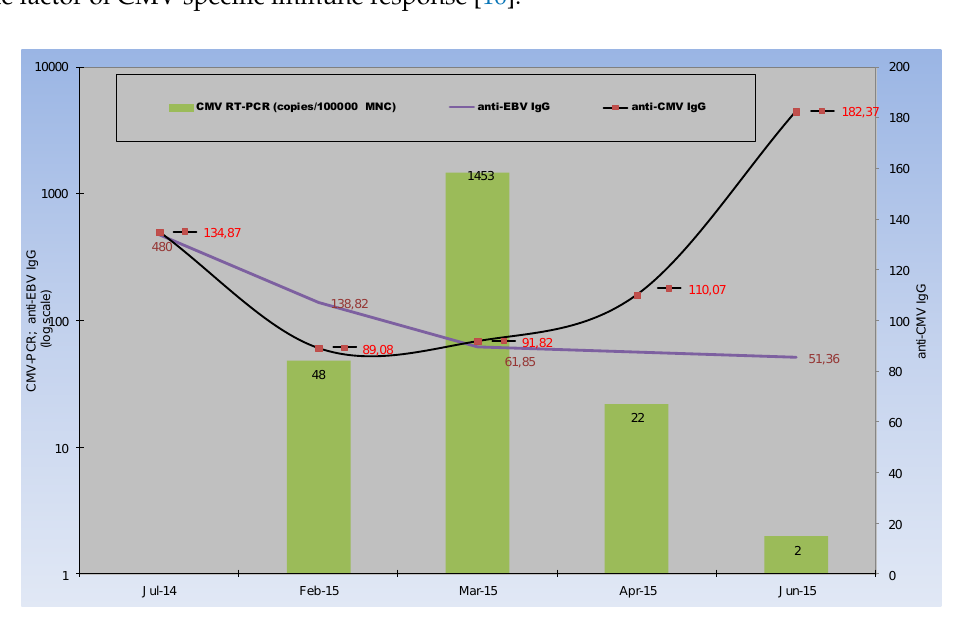
Figure 2. CMV-specific evolution during infancy. The diagram shows the timeline with the results presented on the vertical axes anti-CMV IgG (right) as well as anti-EBV IgG and viremia (left vertical axis). Mild and unspecific symptoms of viremia were observed when the passive-acquired maternal IgG disappeared. Increase of specific IgG corresponds with virus clearance. For comparison spontaneous decrease of maternal EBV-specific IgG was presented without infection and de-novo synthesis (the continuous decrease of EBV-IgG was observed). Significant decrease of maternal CMV-specific IgG precedes virus replication. Table 2. The unique host – virus constellations and populations at risk in transplantology and obstetrics.